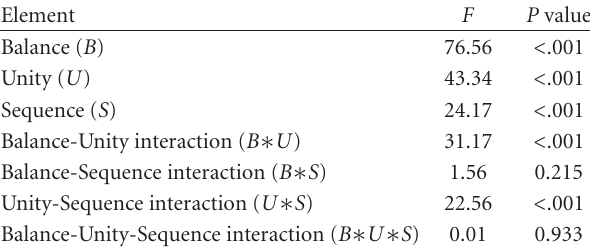
Table 3: Analysis of variance results.